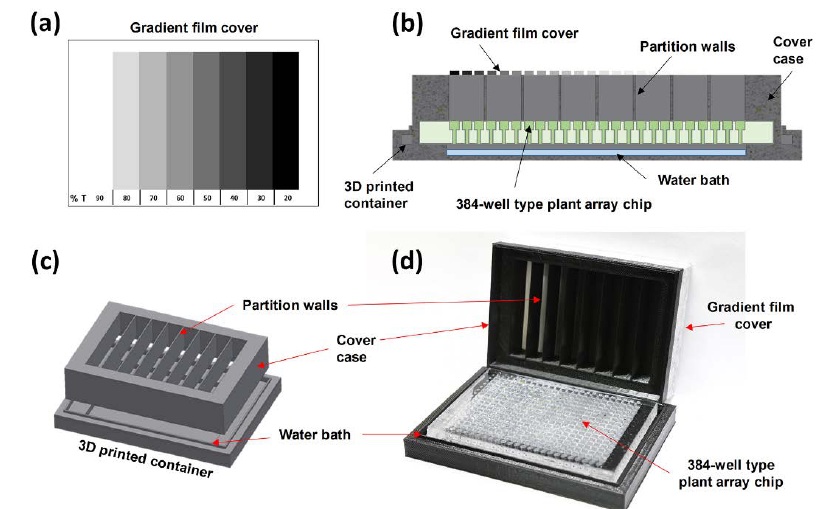
Figure 2 . A light gradient module and the integration of a plant array chip. ( a ) Schematic of a laser- printed light gradient film with eight different light transmittances. % T indicates the transmittance expressed as a fraction of 100. ( b ) Assembly of a 384-well type plant array chip in a light gradient module. ( c ) Schematic of a 3D printed light gradient module case. ( d ) Photograph of a light gradient module and a 384-well type plant array